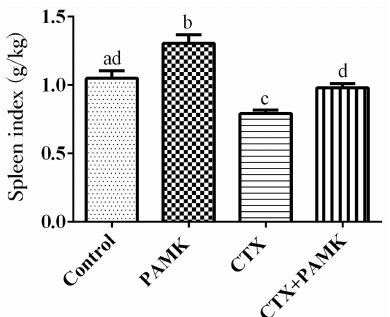
Figure 1. Effects of polysaccharide of Atractylodes macrocephala Koidz (PAMK) on the spleen index decreased by cyclophosphamide (CTX). The data are expressed as the mean ± SD, n = 20. Means with different letters represent statistically significant differences ( p < 0.05); the bars with the same letter are not significantly different ( p >